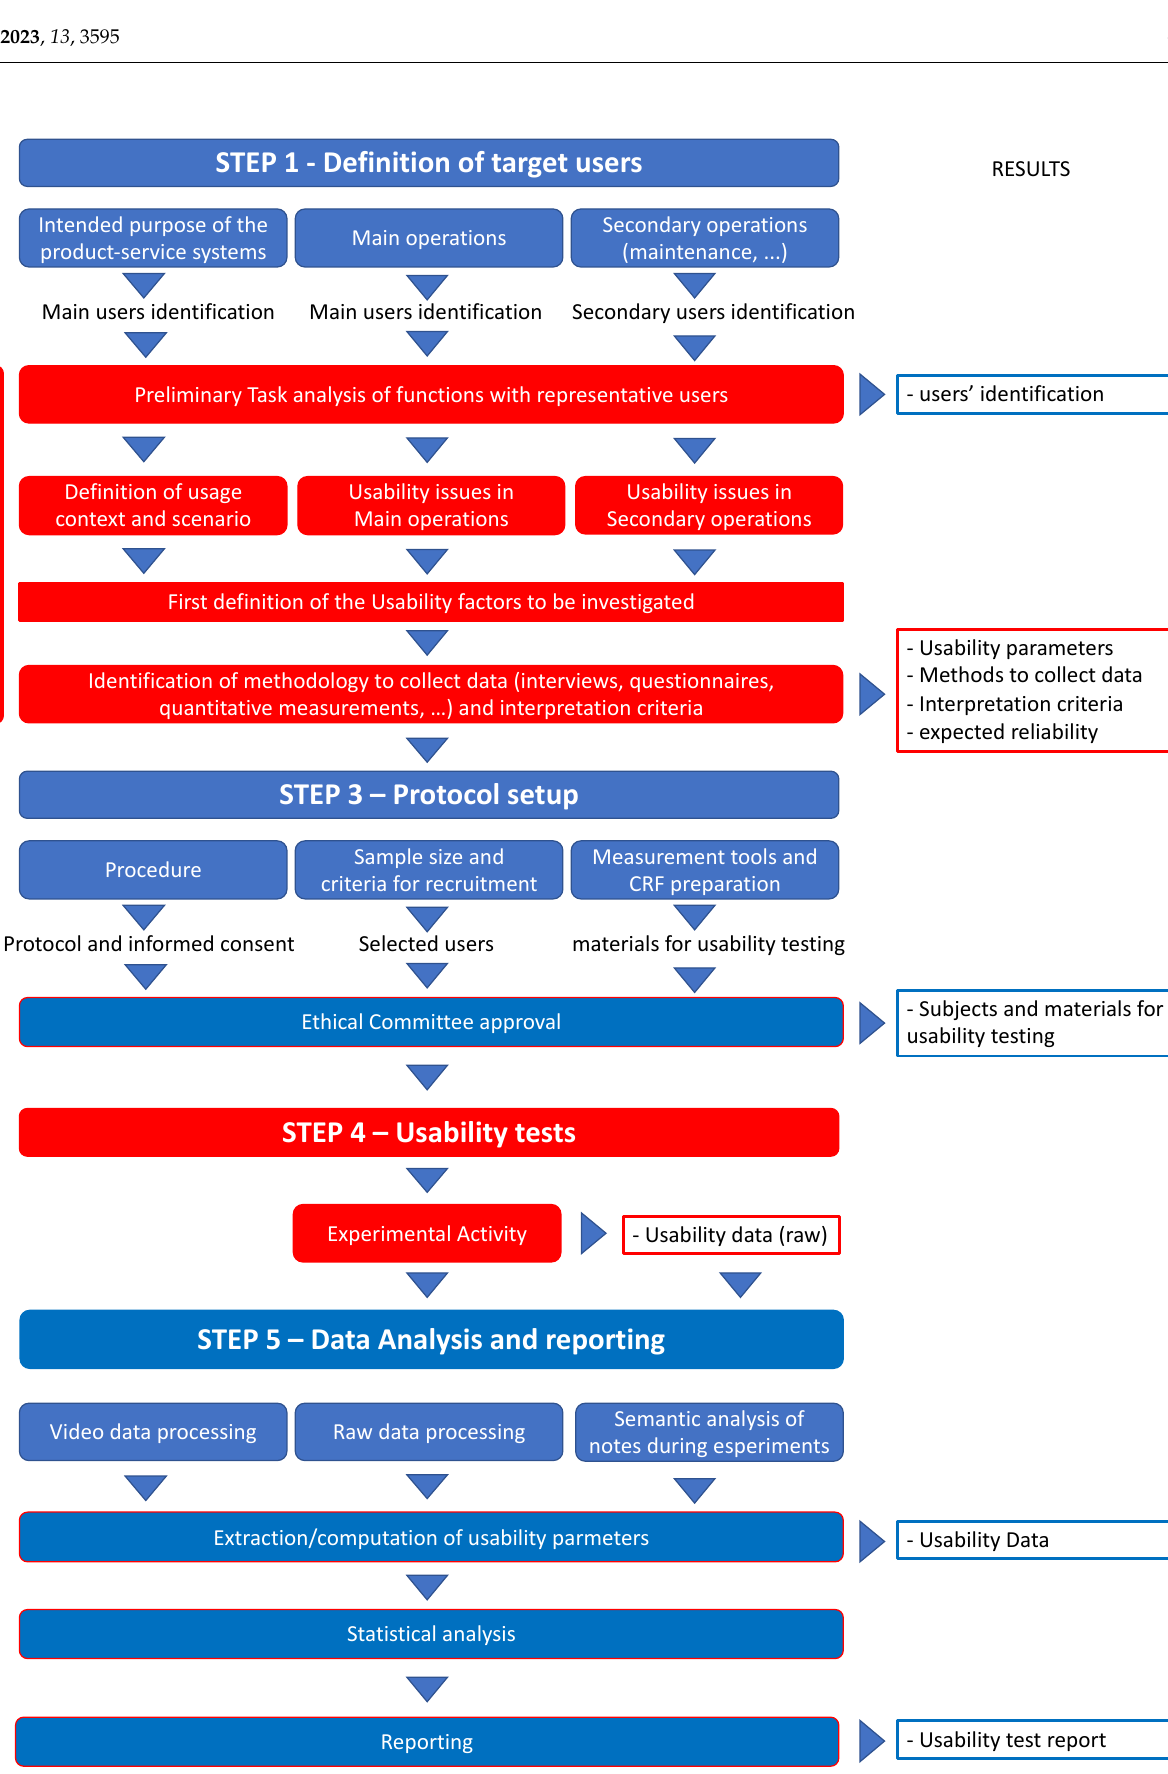
Figure 1. A decision tree describing the proposed methodological approach to prepare a comprehensive usability assessment and the results of each step.